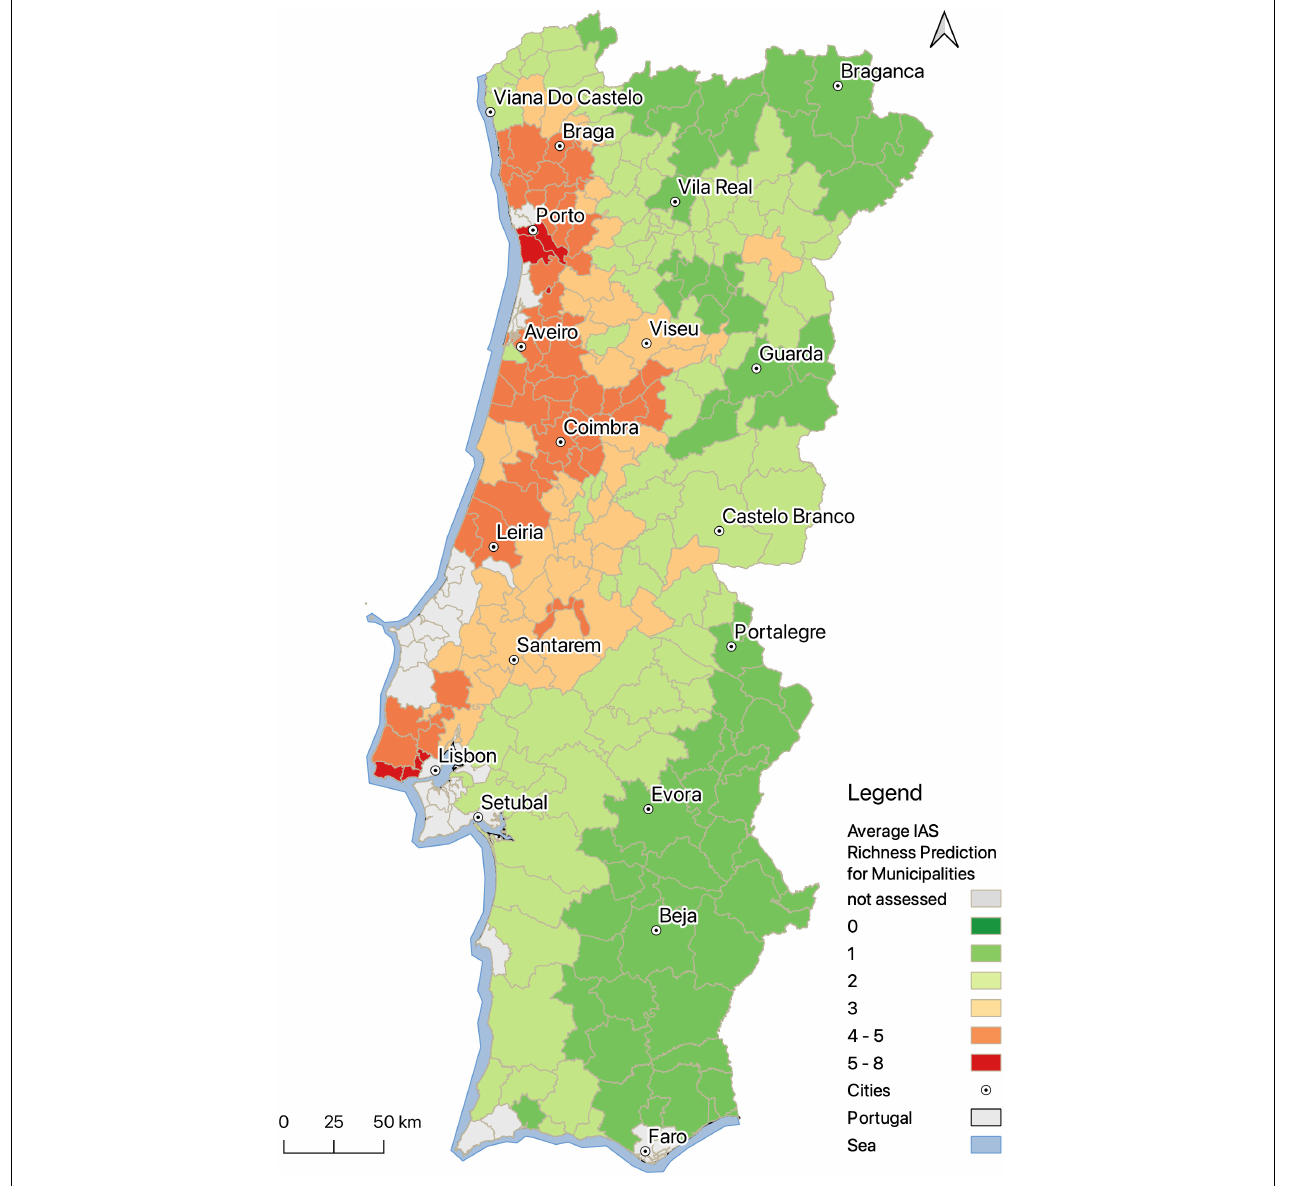
FIGURE 4 | Predictions of invasive alien plant species richness for municipalities in Portugal. Predictions correspond to mean values of richness obtained for the 1 km grid cells representing river sections located within the municipality. Gray areas correspond to river basins that were not analyzed due to insufficient data. This figure was created with QGIS Version 3.14 (QGIS Development Team,